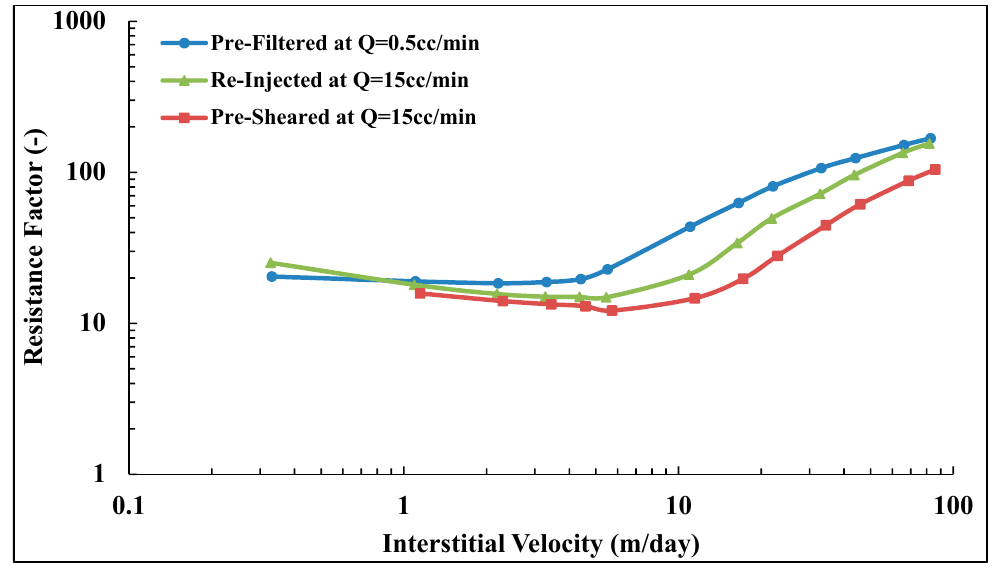
Figure 10. Resistance factor ( RF ) versus interstitial velocity for Solution B (Concentration = 1000 ppm, MW = 12 MDa). Table 5. Core and solution properties for injected Solution B (Concentration = 1000 ppm, MW = 12 MDa).